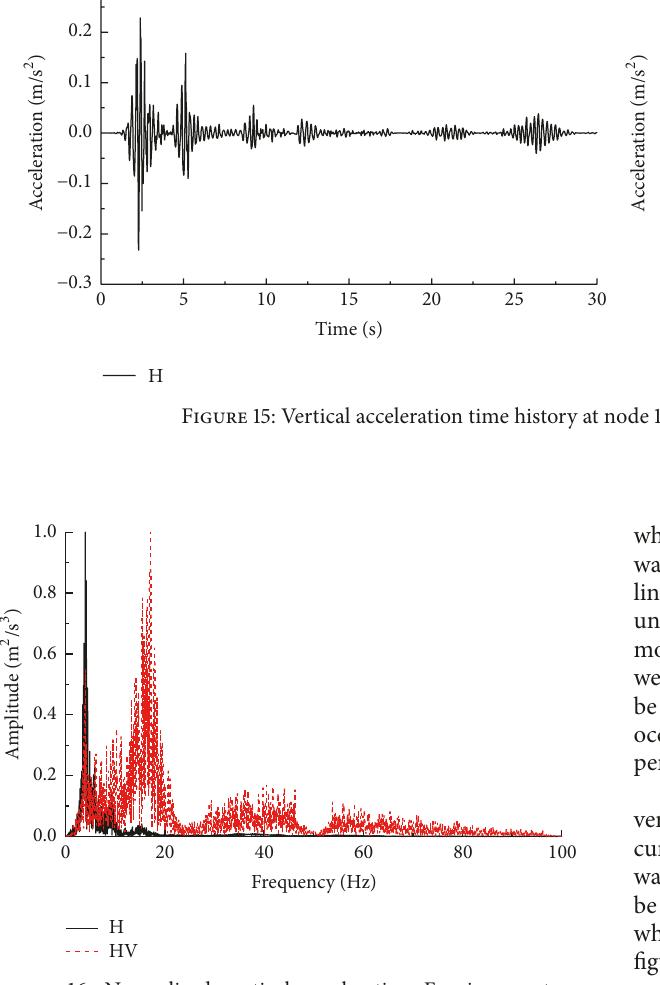
Figure 16: Normalized vertical acceleration Fourier spectrum curves at node 103 under EL wave for H case and HV